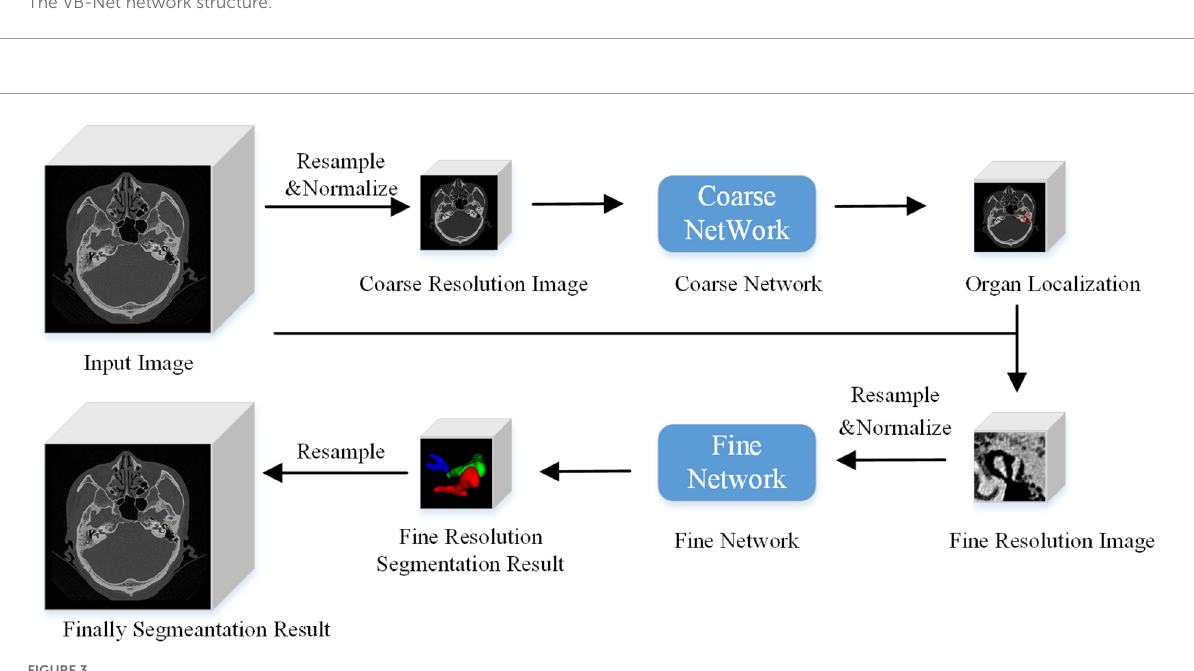
FIGURE3 Algorithm flow